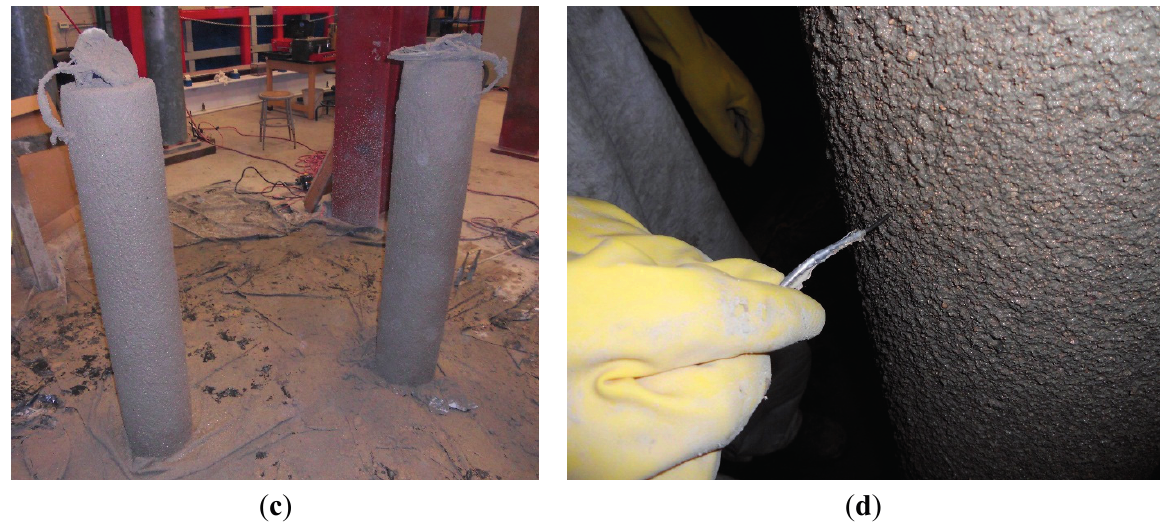
Figure 8. Complete process of Tyfo ® CFP fire protection system application: ( a ) VG primer application; ( b ) VG dash coat application; ( c ) WR-AFP application; ( d ) thickness